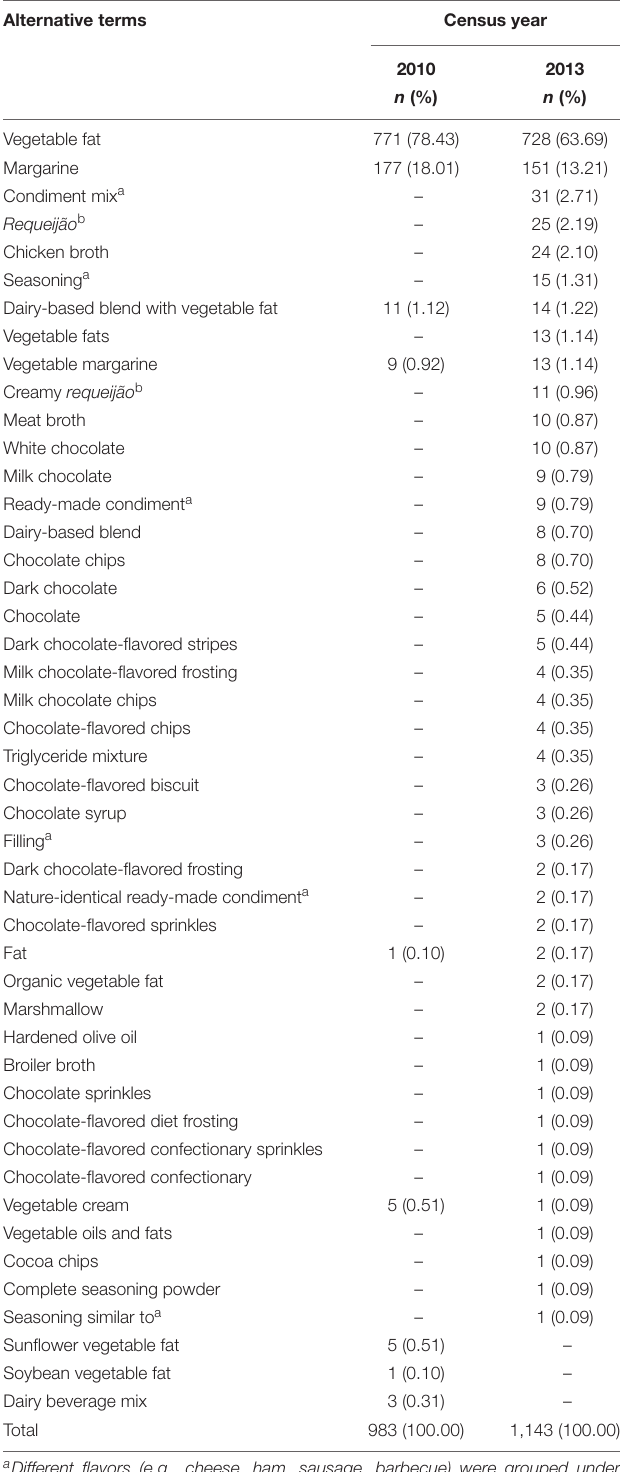
TABLE 3 | Alternative terms for sources of industrially produced trans-fat acids and their frequency of occurrence on the ingredients list of packaged foods sold in Brazilian supermarkets, as assessed by the food label census method in 2010 and